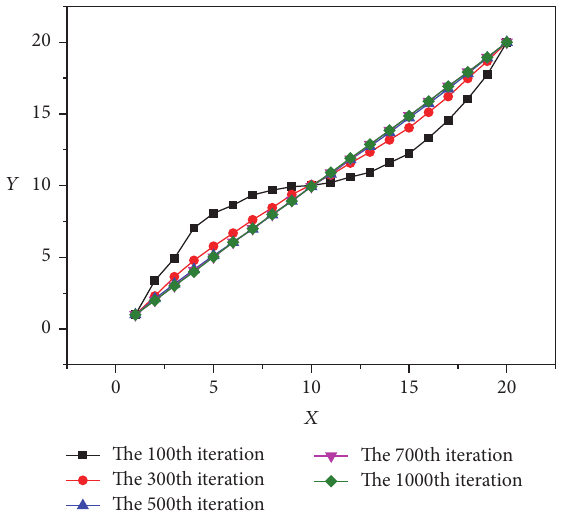
Figure 7: Routes sketch of different generations in optimization.